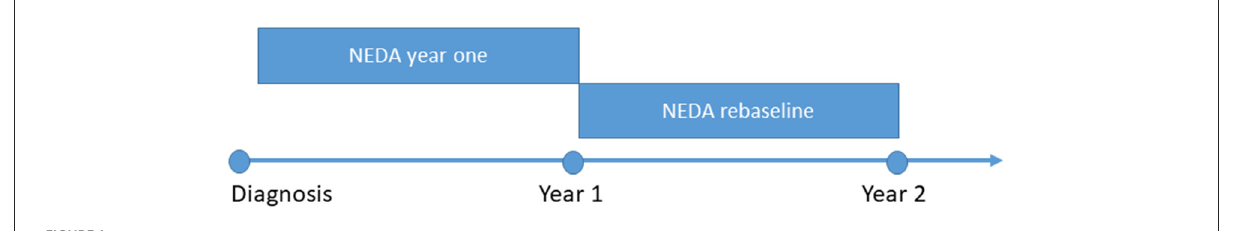
FIGURE1 Definitions of NEDA used in this paper. NEDA no evidence of disease